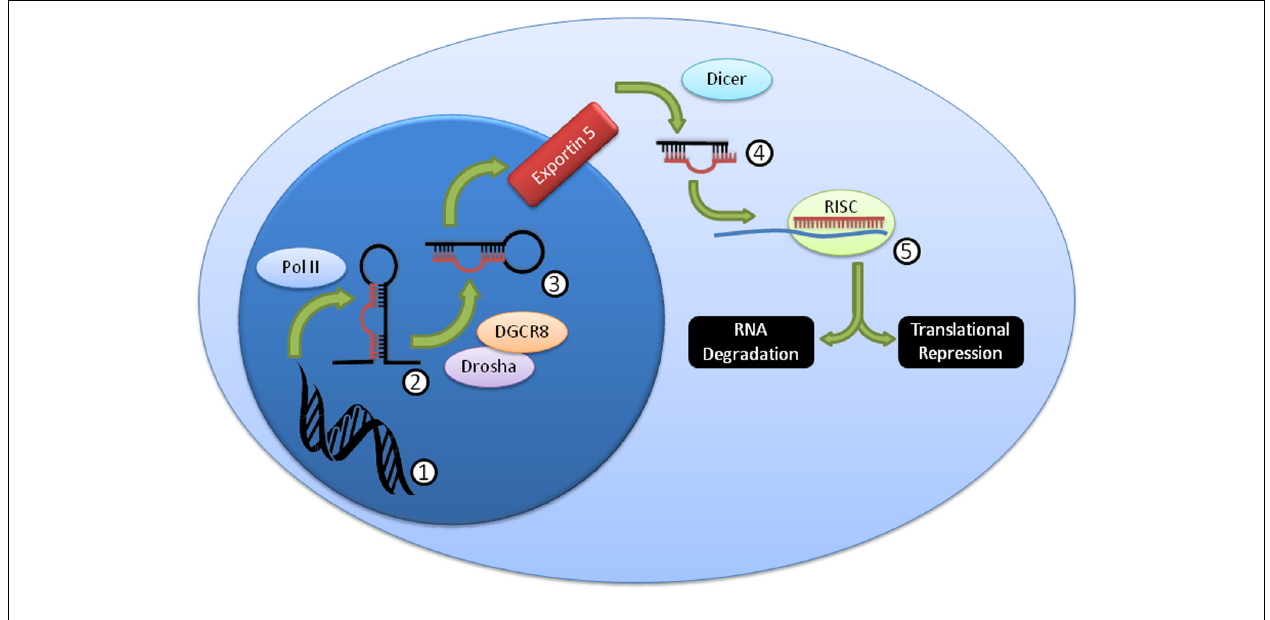
mature miRNA duplex (4).This duplex is unwound, and one strand, the mature miRNA, is loaded into the RISC complex (5), where it usually binds imperfectly to a target mRNA and mediates RNA degradation and/or translational